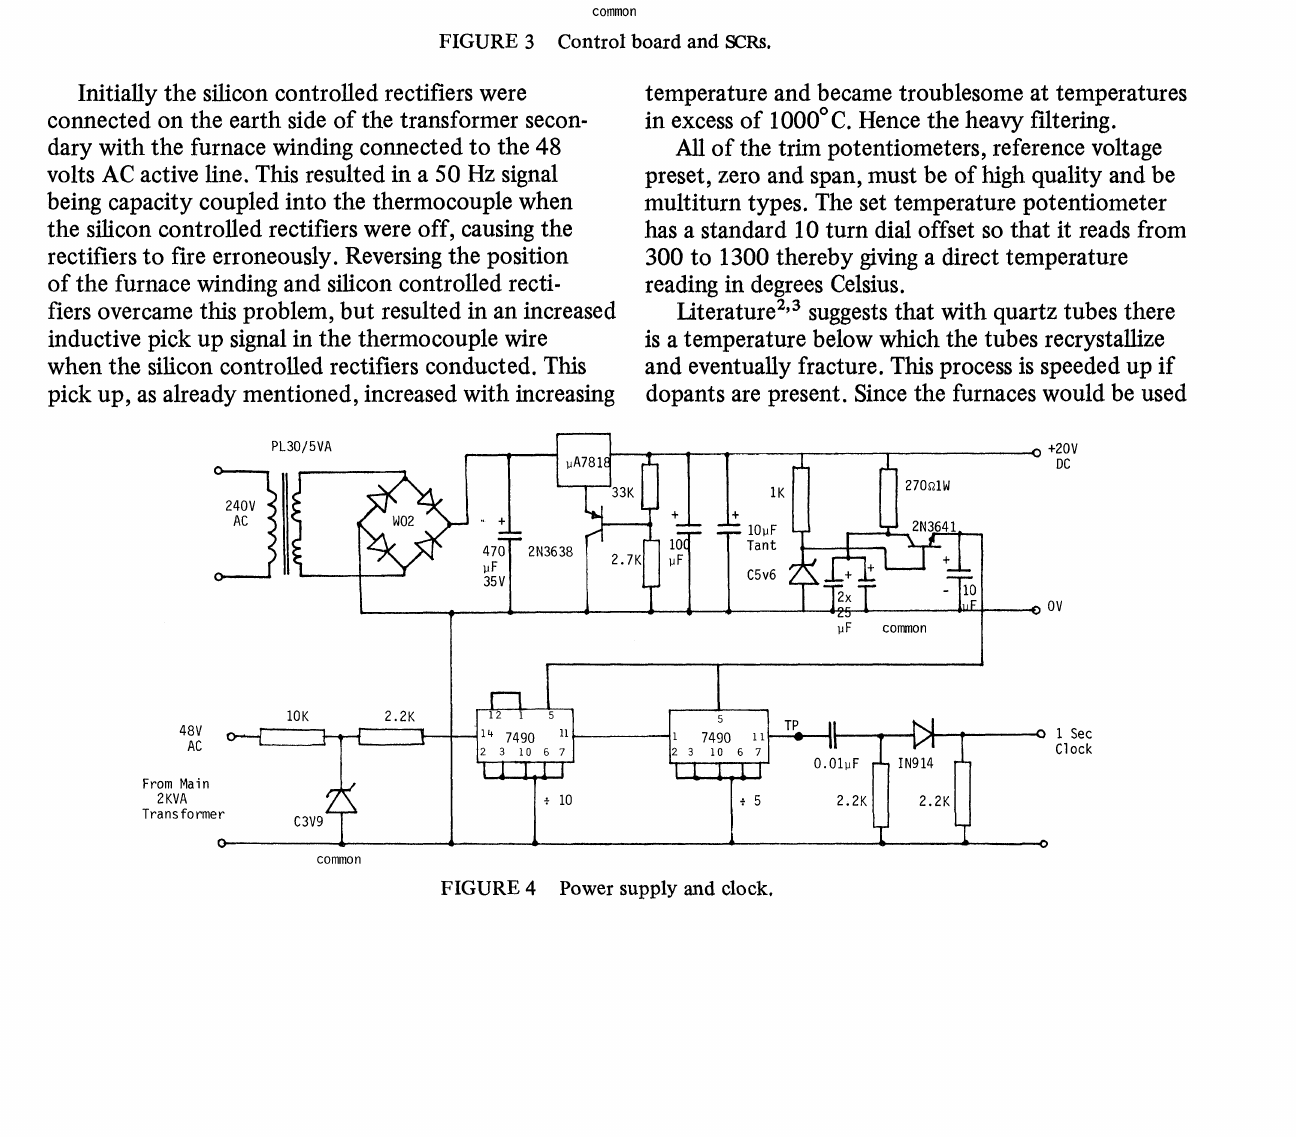
FIGURE 3 Control board and SCRs.